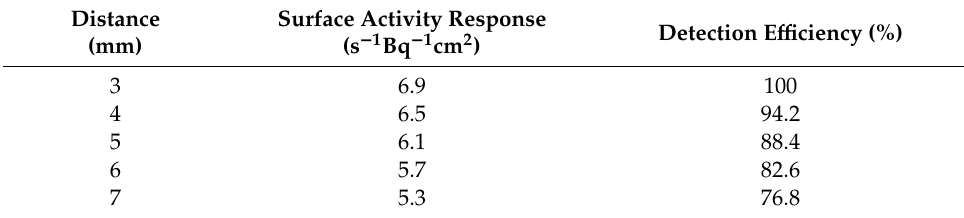
Table 4. The source of α particle surface activity response test at difference distance.